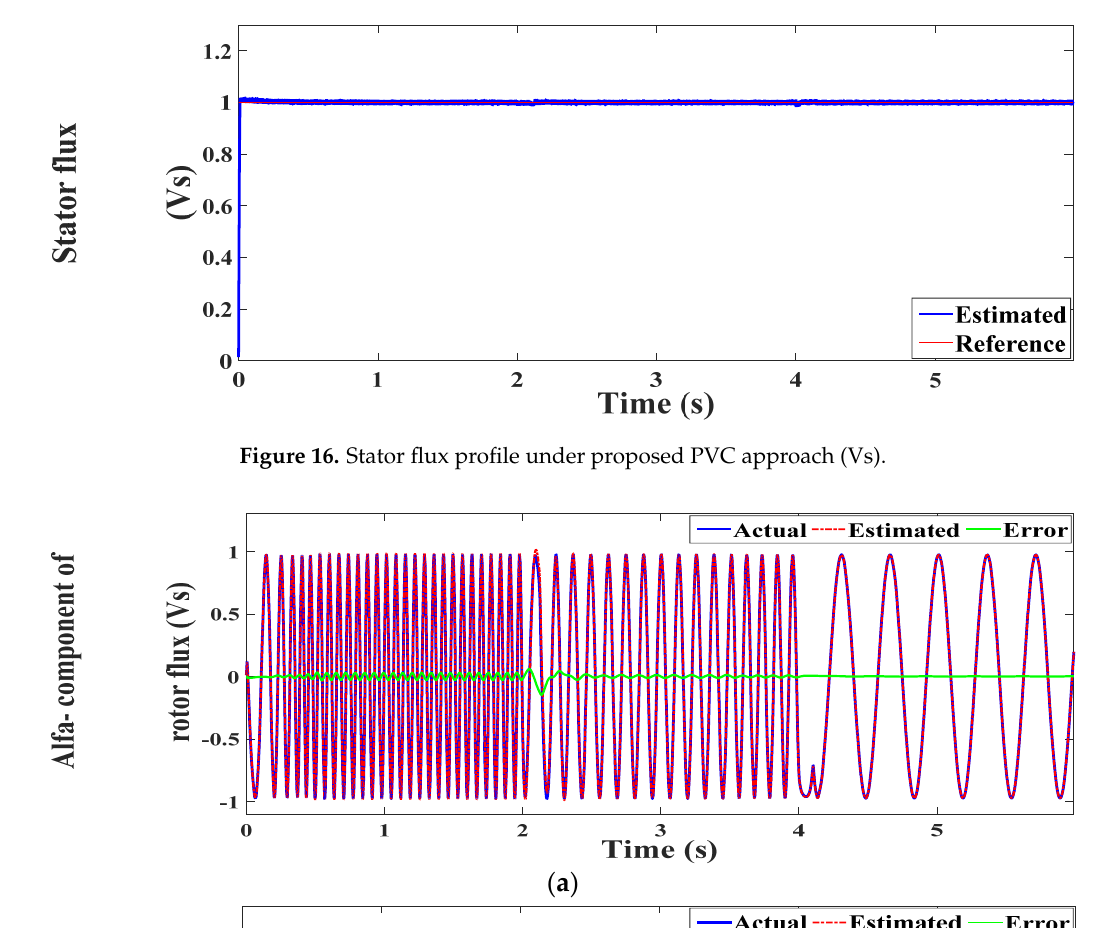
Figure 15. Torque profile under proposed PVC approach (Nm).